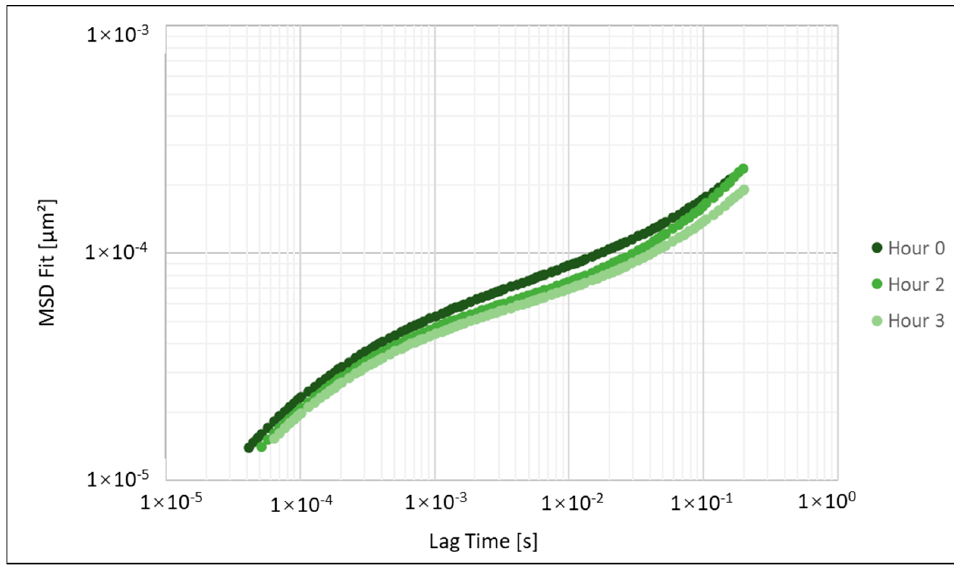
Figure 8. 3.7 wt % CAPB, 3.7 wt % SLES, 15 wt % avocado oil emulsion variation in MSD values over a 3 ‐ h period.